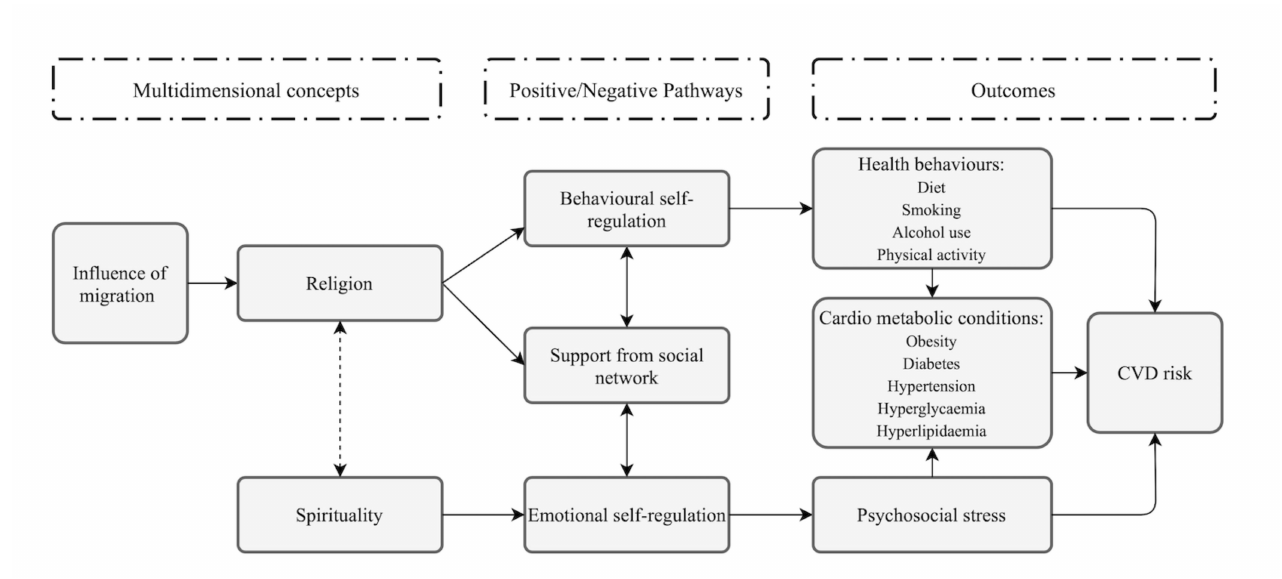
Figure 1. Conceptual framework of potential mechanisms relating religion/spirituality to cardiovascular disease (CVD) risk among African non-migrants and